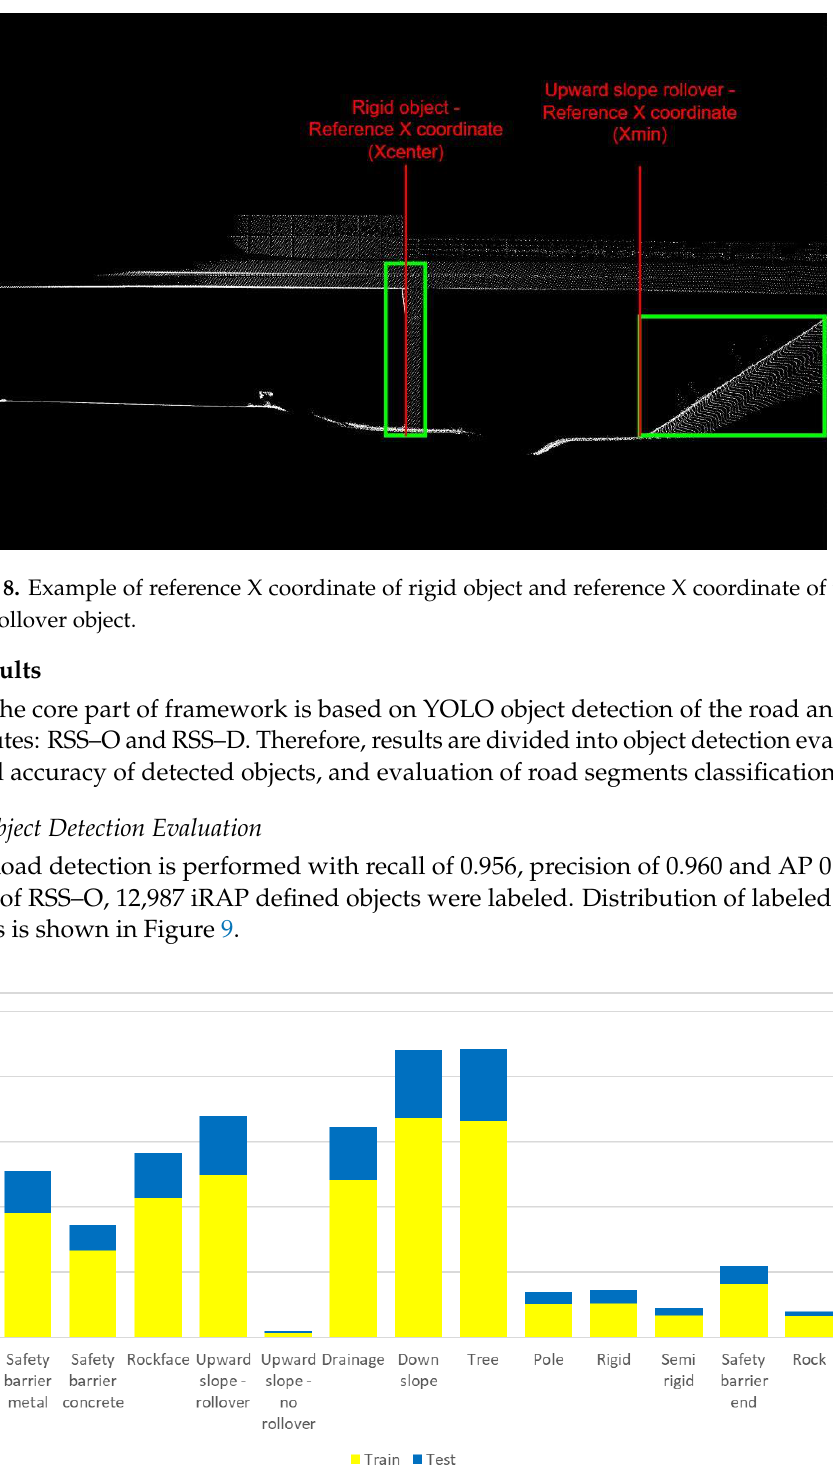
Table 2. Confusion matrix for predicted and ground truth objects presented with percentage.